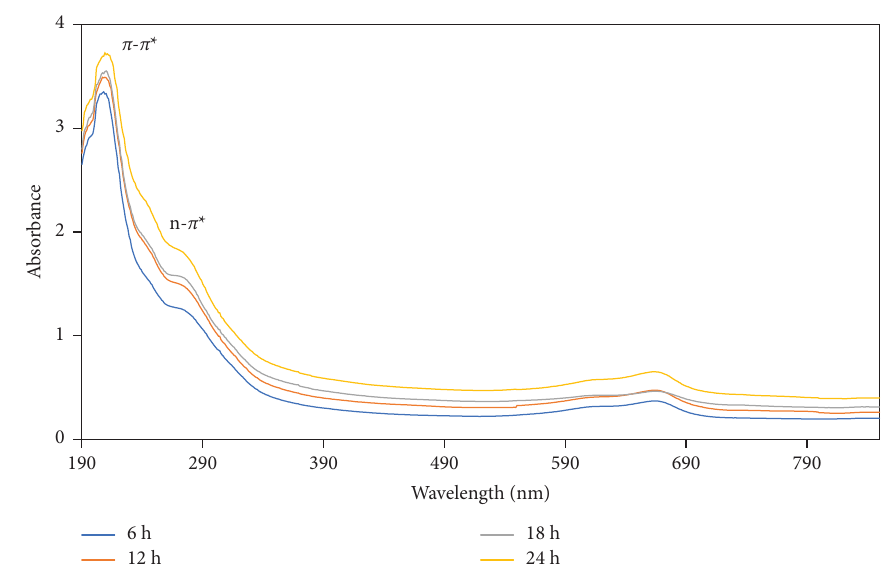
Figure 2: UV-Vis spectra of CQDs prepared at 180 ° C after diferent time intervals.